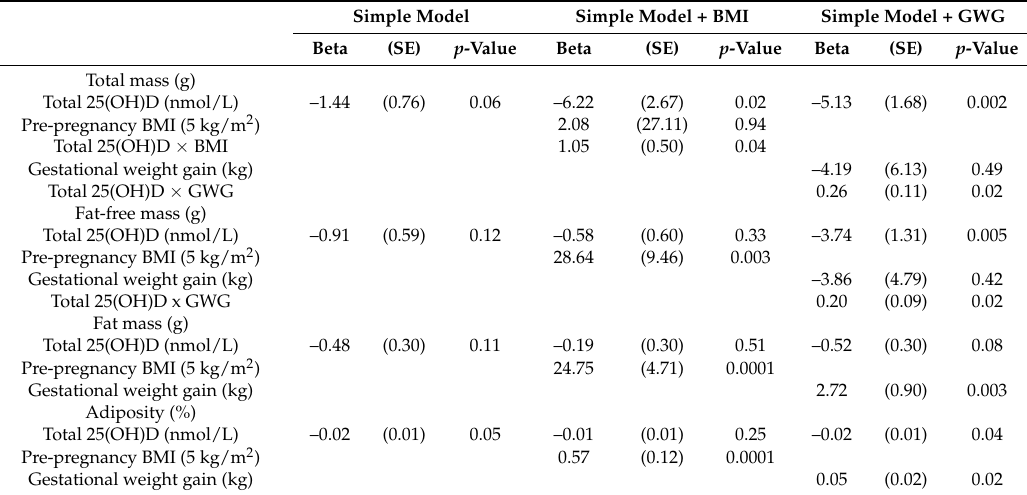
Table 3. Associations between cord blood 25(OH)D and offspring body size and composition at birth ( n = 605)